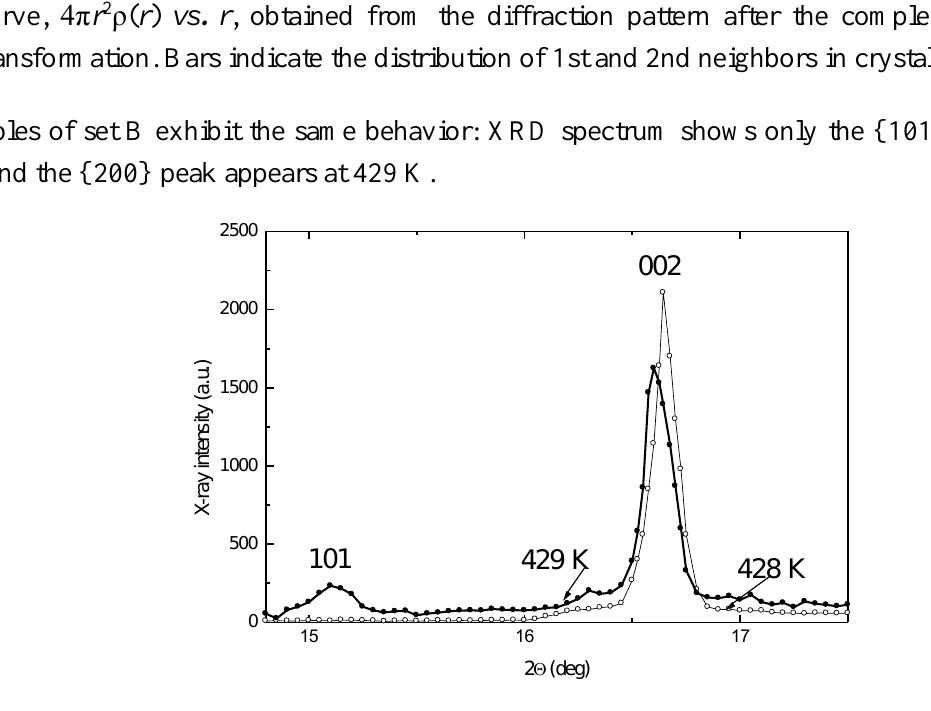
Figure 5. The XRD pattern of samples of set A recorded at 428 K, just below T M , is compared with the contribution from solid to the overall pattern at 429